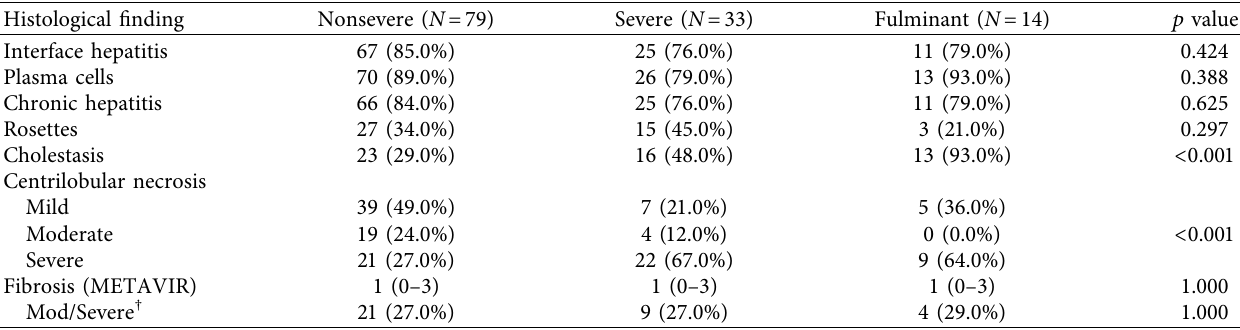
Table 6: Histological findings from liver biopsies according to disease